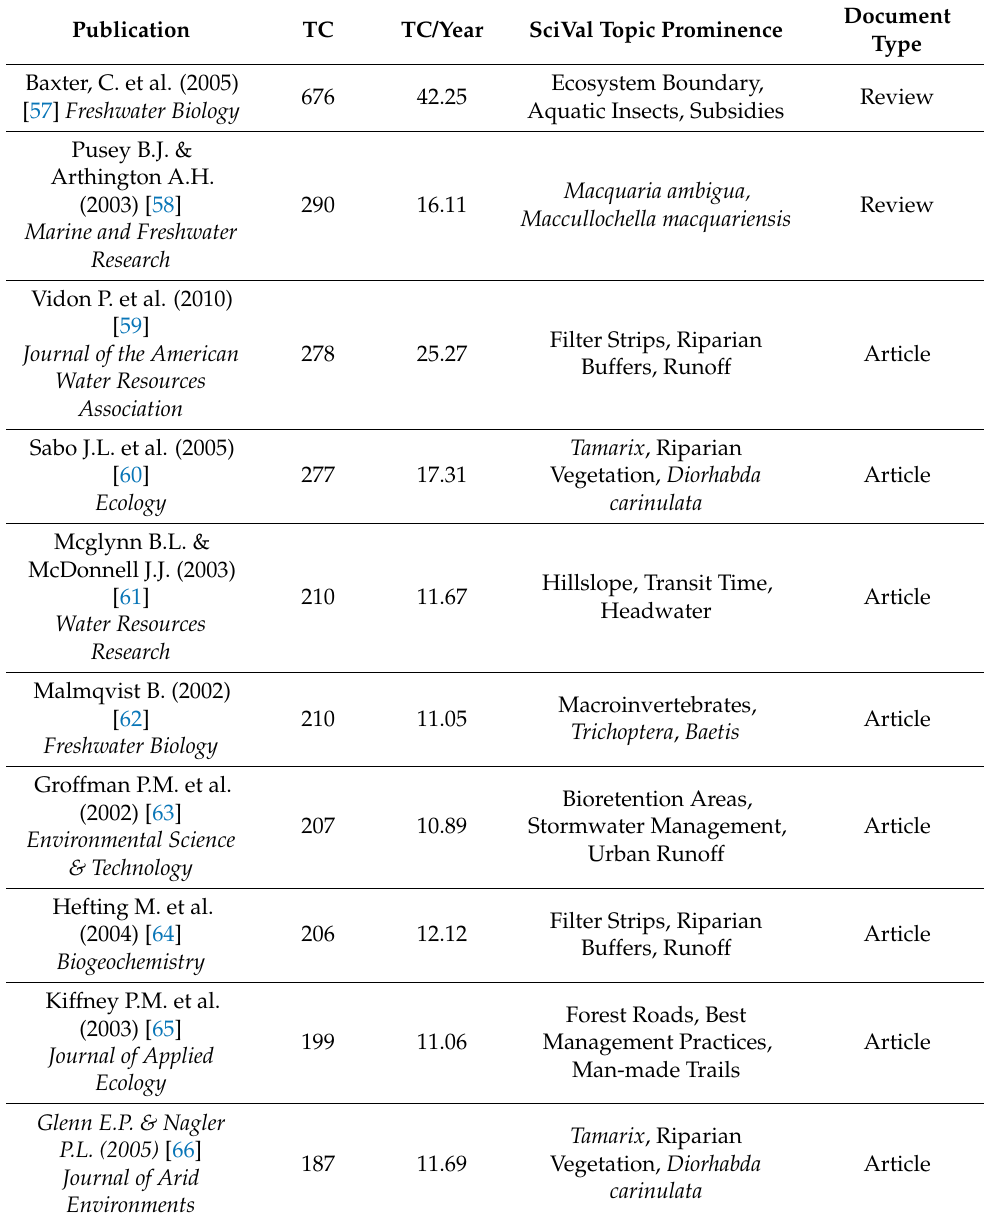
Table 1. Top 10 most cited publications under the query performed (search date: 27-11-2020). Topics were gathered from the SciVal Topic Prominence in Science service (Elsevier). TC = Total